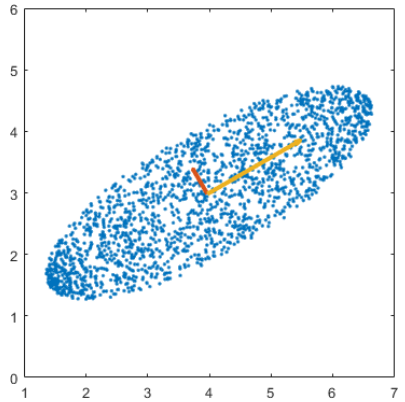
Figure 2. Principal components of a sample synthetic